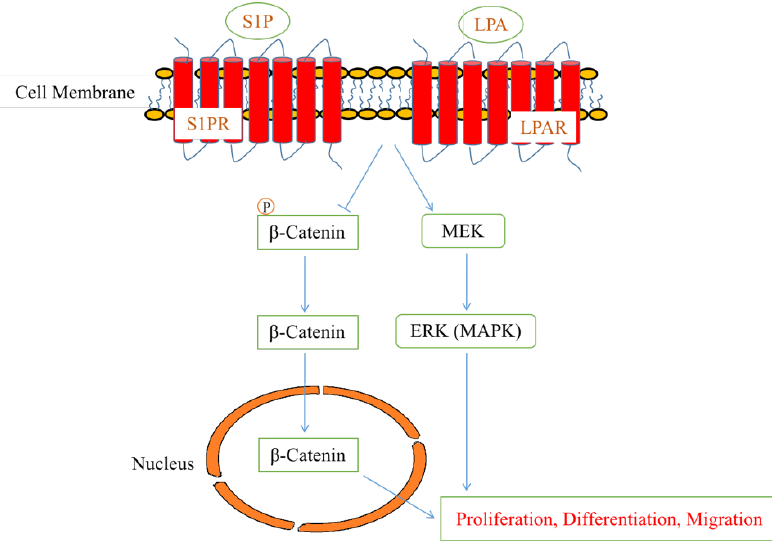
Figure 3. Lysophospholipid signaling in induced pluripotent stem cells (iPSCs). When introduced to iPSCs during the cardiomyocyte differentiation process, S1P and LPA bind to their respective GPCRs to activate the Wnt/β -catenin and MAPK signaling pathways. S1P and LPA facilitate nuclear localization of β -catenin, likely by increasing the available pool of its non-phosphorylated form. They also activate MEK (MAPKK), which then activates ERK (MAPK), leading to cell cycle progression. The downstream effects of S1P and LPA include enhanced cardiac differentiation of iPSCs and increased cellular proliferation and migration. The mechanisms described in this figure may recapitulate the pathways activated by lysophospholipids in the regulation of cardiovascular development in vivo. Abbreviations: GPCR, G-protein coupled receptor; iPSC, induced pluripotent stem cell; LPA, lysophosphatidic acid; LPAR, LPA receptor; MAPK, mitogen-activated protein kinase; S1P, sphingosine-1-phosphate; S1PR, S1P receptor.